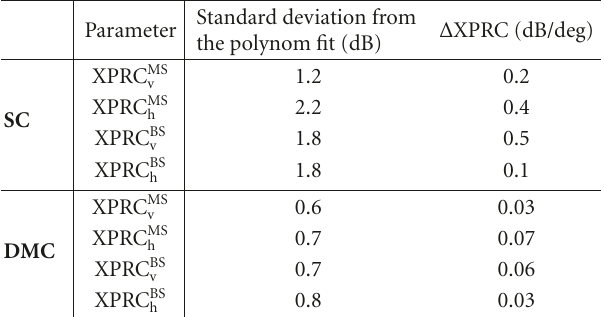
Table 6: Δ XPRC segments Rx6 to Rx19. Standard deviation from Parameter the polynom fit (dB)